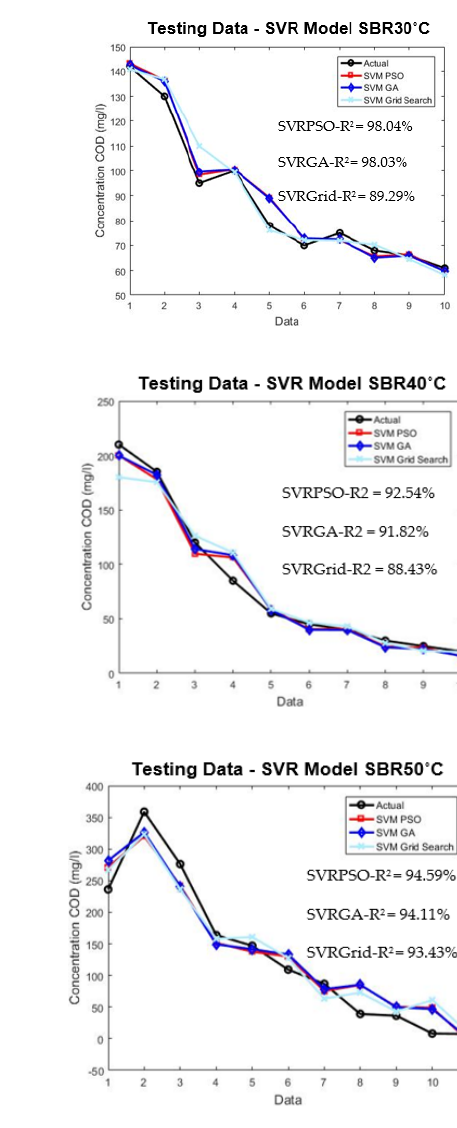
Figure 9. Plotted optimized SVR model for training and testing for SBR30 °C, SBR40 °C, and SBR50 °C. Table 6. Performance comparison between optimize SVR models at different temperature.